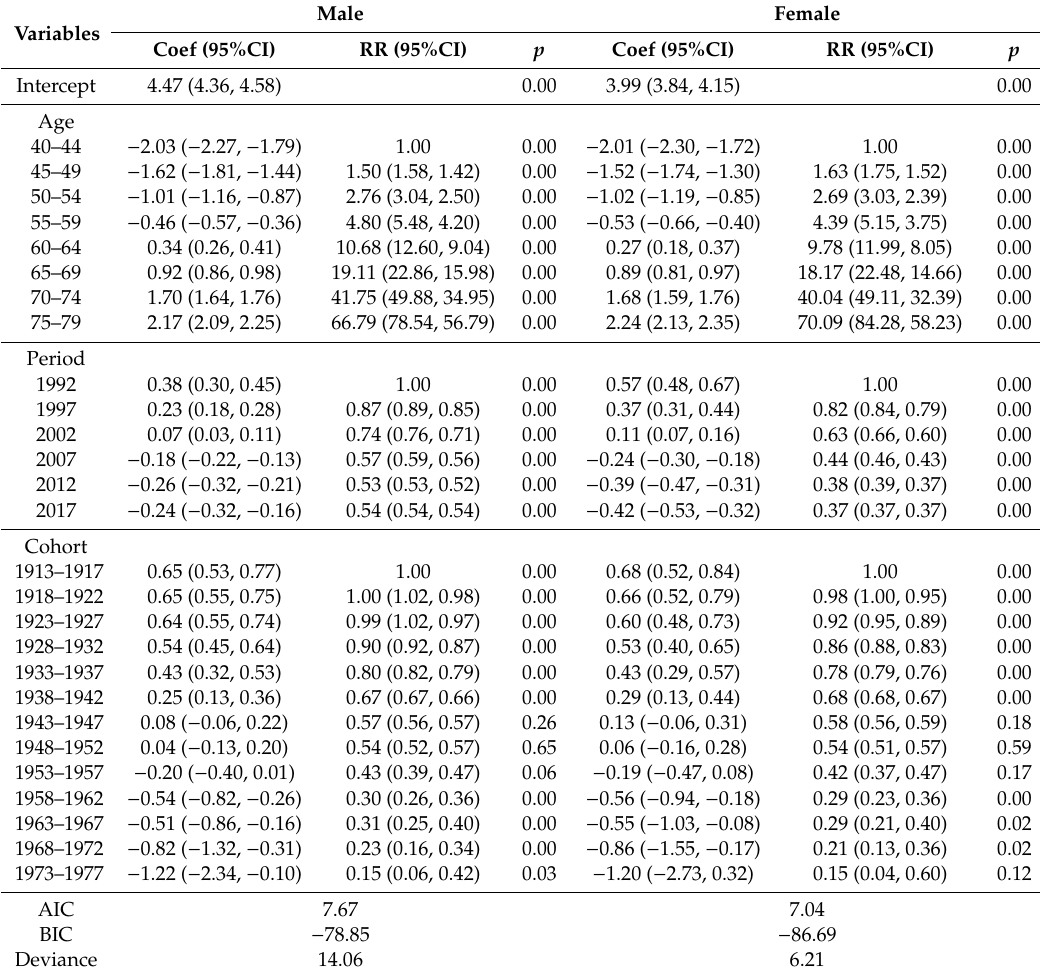
Table A1. APC model analysis results of COPD mortality in China,